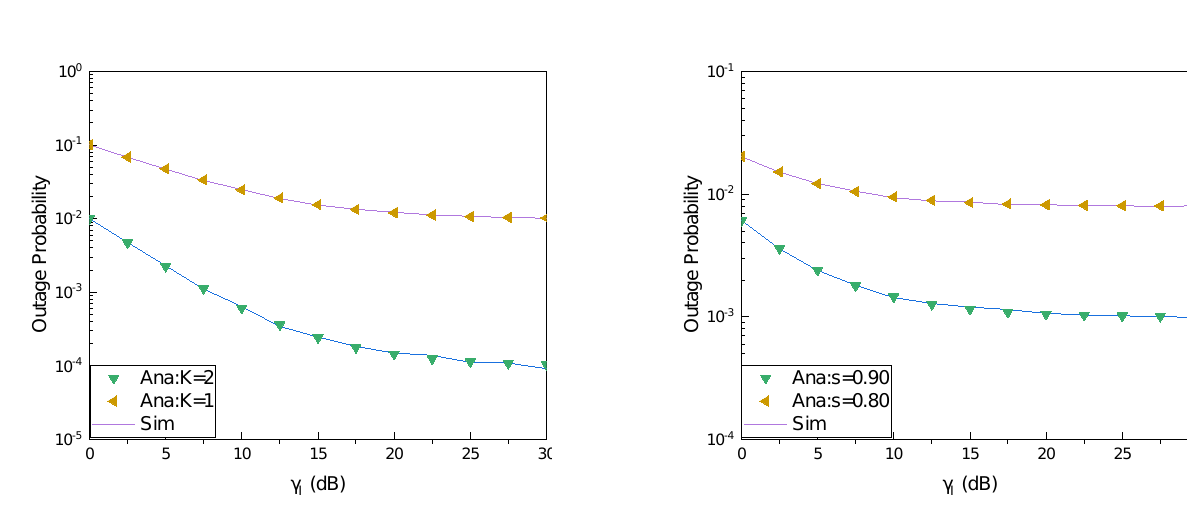
Figure 2. The impact of the number of small cells on system performance (s=0.99)